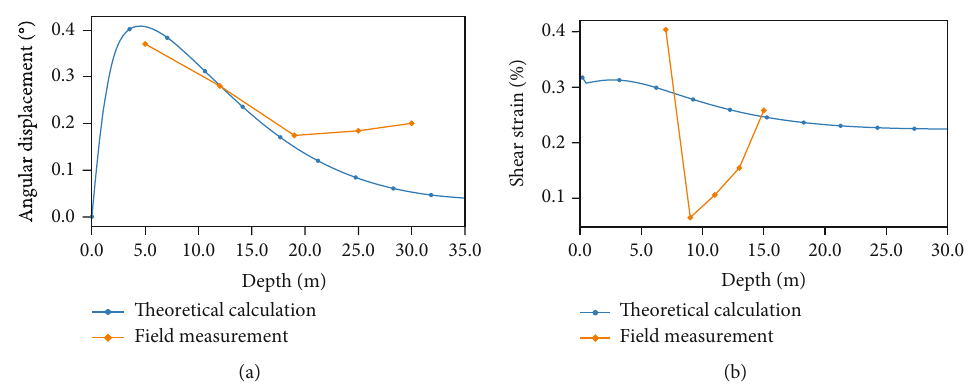
Figure 13: Station